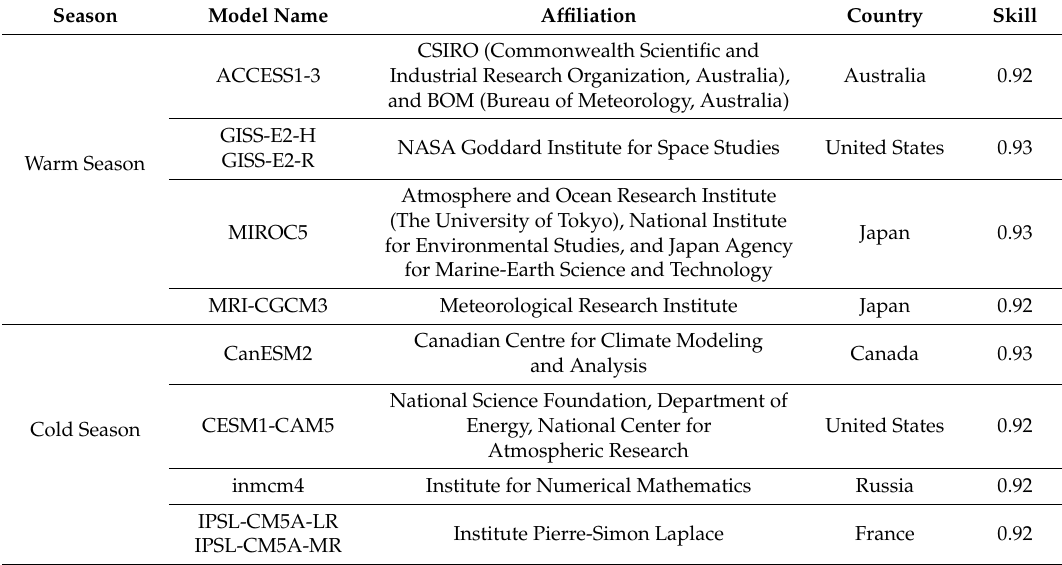
Table 1. List of CMIP5 models evaluated in each season. Top five models of 32 as identified by application of skill scores (averaged across all climate divisions)